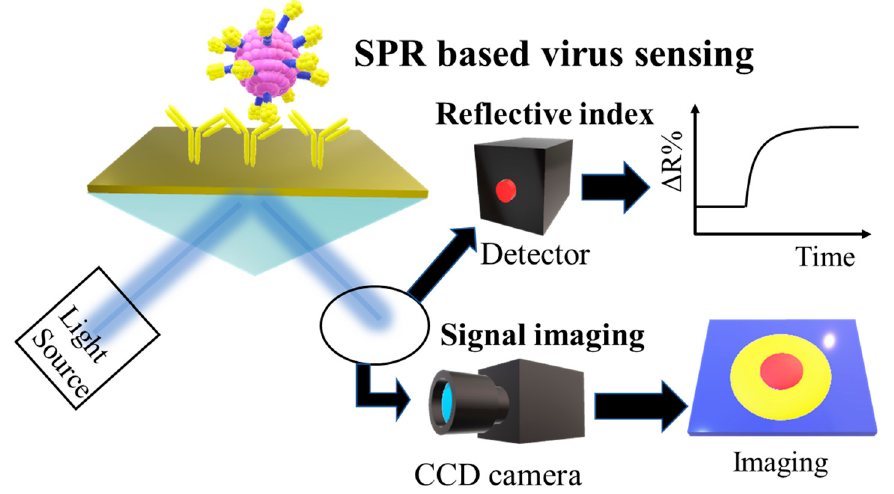
Figure 2. Schematic diagram of SPR-applied virus detection. The reflected light from the light source irradiated on the Kretschmann configuration is captured by the detector or CCD camera and processed and analyzed as a signal.